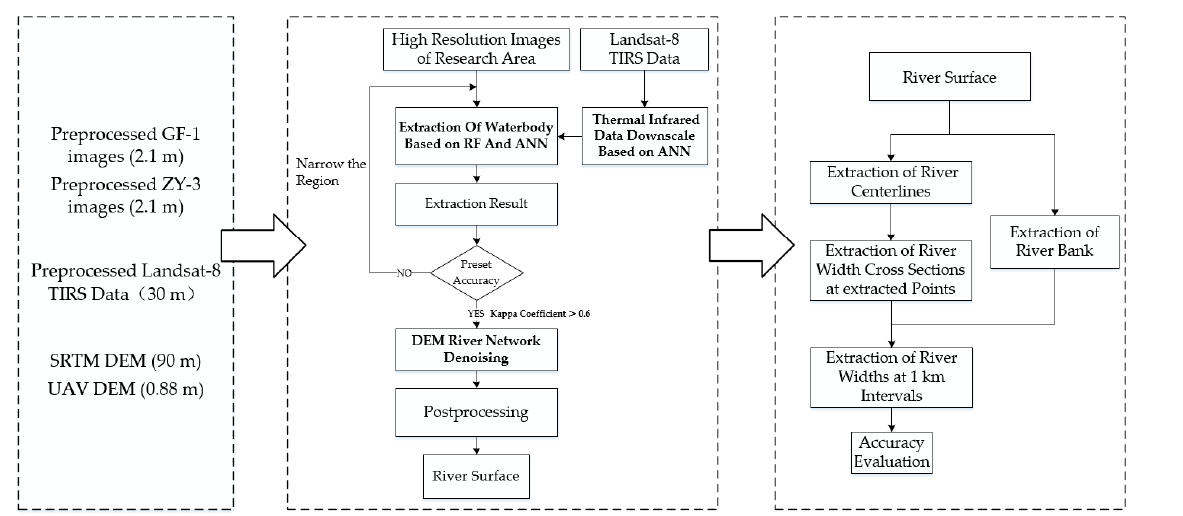
Figure 5. Technical route of river surface and river width extraction.